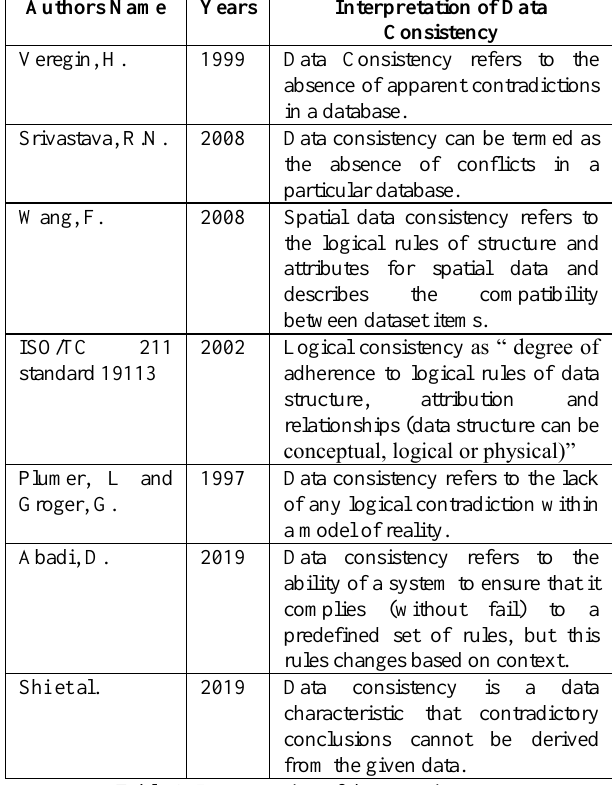
consistency. Table 1 show the interpretation of data consistency based on different purposes.